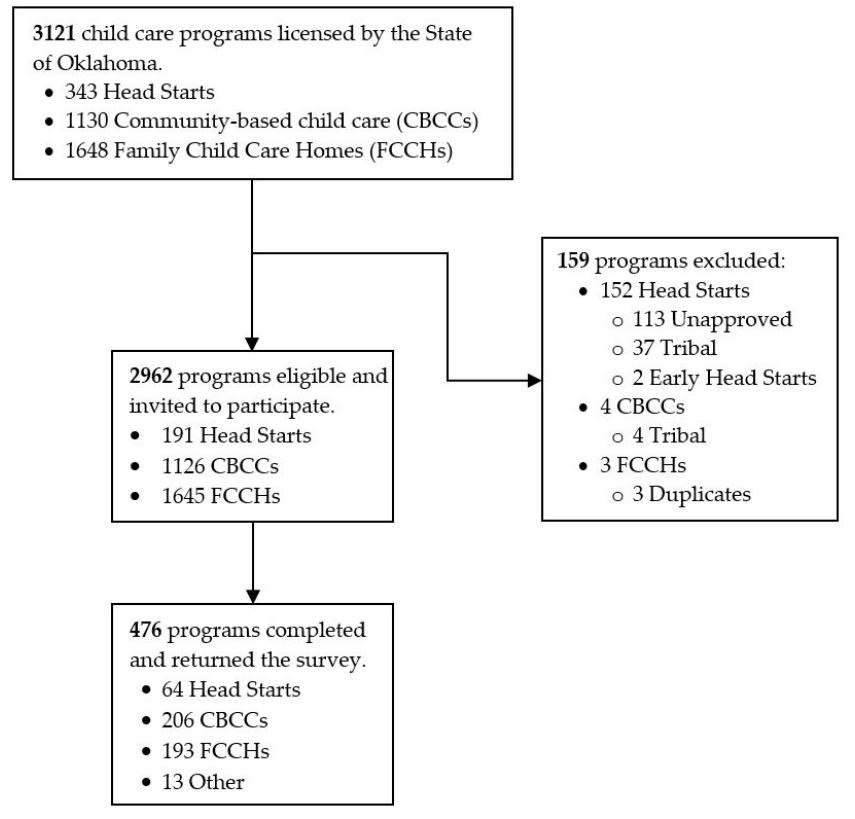
Figure 1. Program participation in the Communities and Classroom Health Survey ( n = 476), Oklahoma 2019–2020.